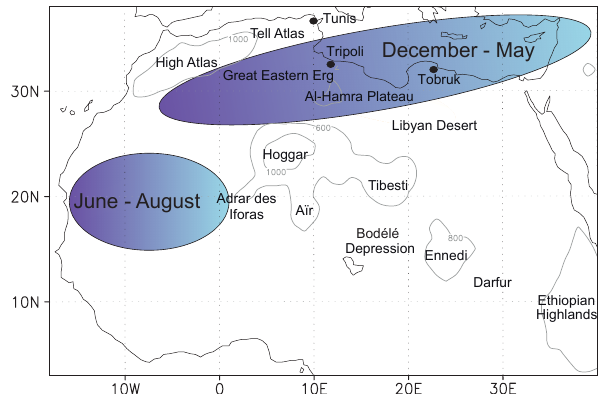
Figure 5. Schematic overview on regions of most frequent cyclone occurrence. Contours show the orography based on ERA-Interim. Geographical terms used in the text are